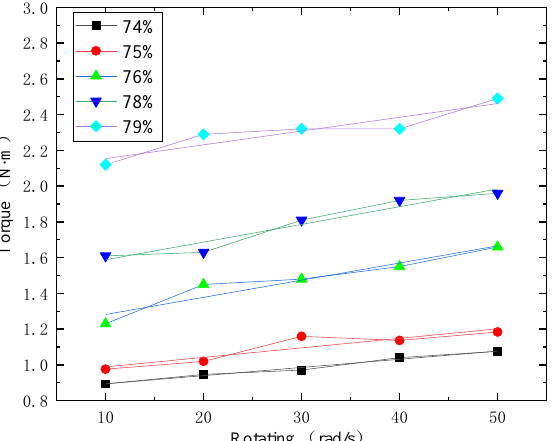
Figure 7. Relation between rotating speed and torque at different concentrations.